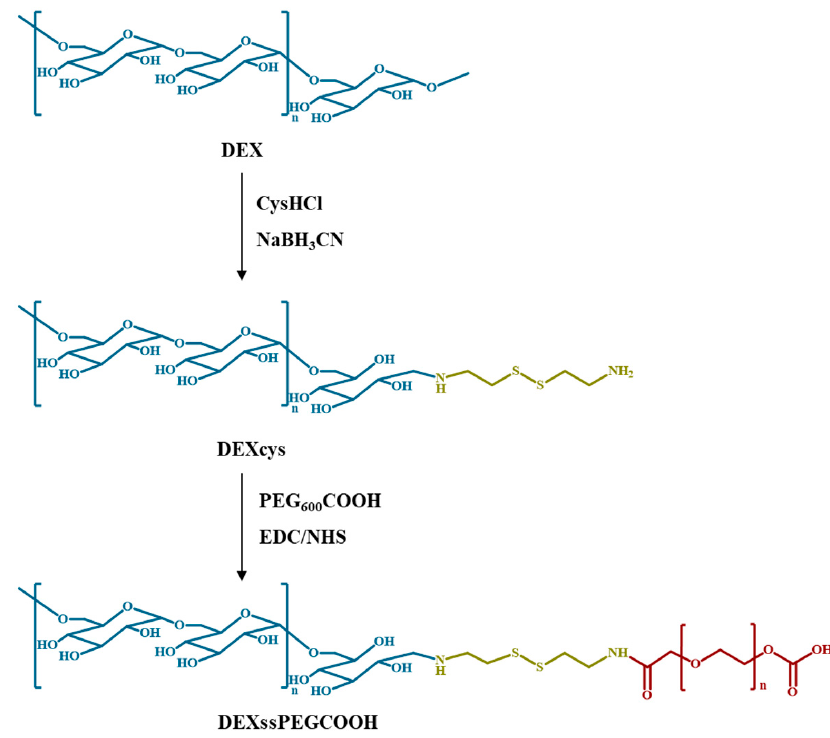
Figure 1. Synthesis of DEXcys and DEXssPEGCOOH.